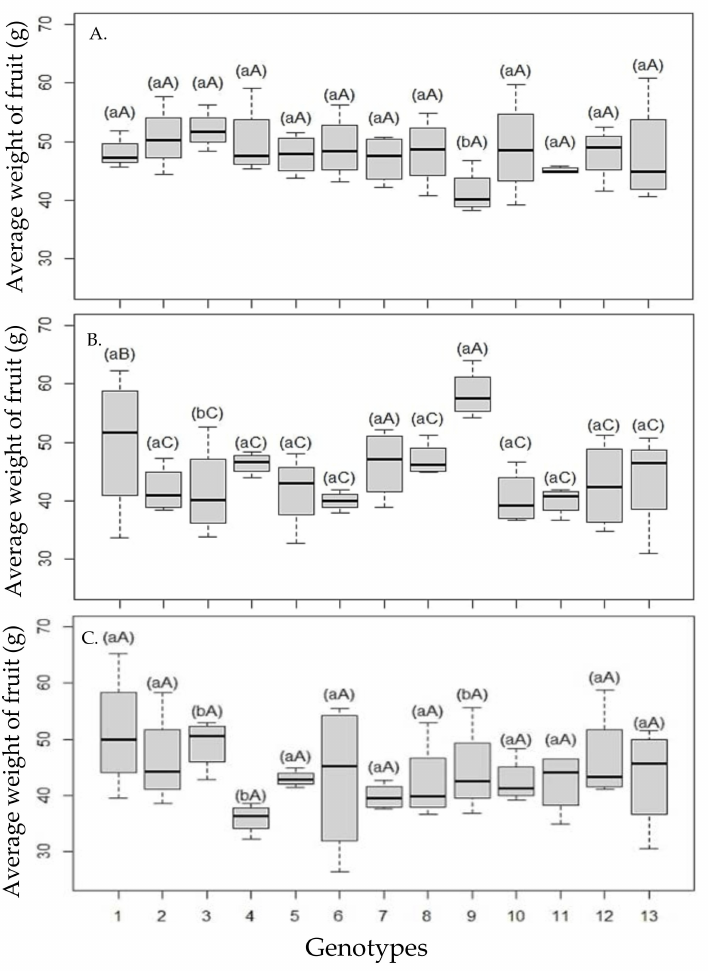
Figure 3. Boxplot relative to the average weight of fruit of 13 citrus rootstocks in combination with ‘Tahiti’ acid lime ( Citrus × latifolia (Yu. Tanaka) Tanaka) under irrigation with waters of 0.14 ( A ), 2.40 ( B ), and 4.80 dS m − 1 ( C ), in the first year. For identification of genotypes, see Table 1. Boxplots with the same lowercase letter do not differ statistically, according to the Tukey test between salinity levels ( p ≤ 0.05), and those with the same uppercase letter belong to the same genotype group, according to the Scott–Knott test ( p ≤